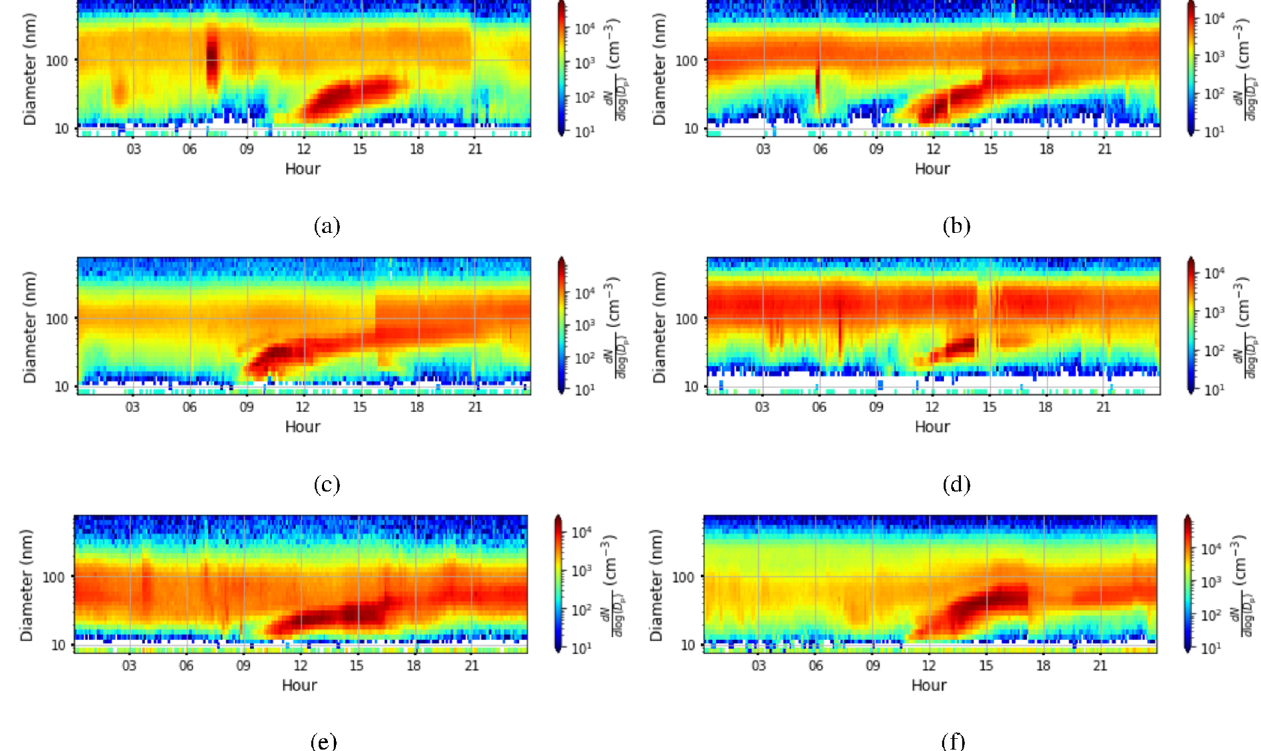
Figure B1. Aerosol particle size distribution measured at the surface (the colour indicates the concentration d N/ dlog( d p ) in cm − 3 ) on (a) 23 March 2018, (b) 20 April 2018, (c) 7 May 2018, (d) 13 August 2018, (e) 6 November 2018, and (f) 13 February 2019. For all figures, the time axis is local time (hours UTC + 4). Visually estimated aerosol particle growth rates from the figures are (a) 6 . 7nmh − 1 , (b) 6 . 7nmh − 1